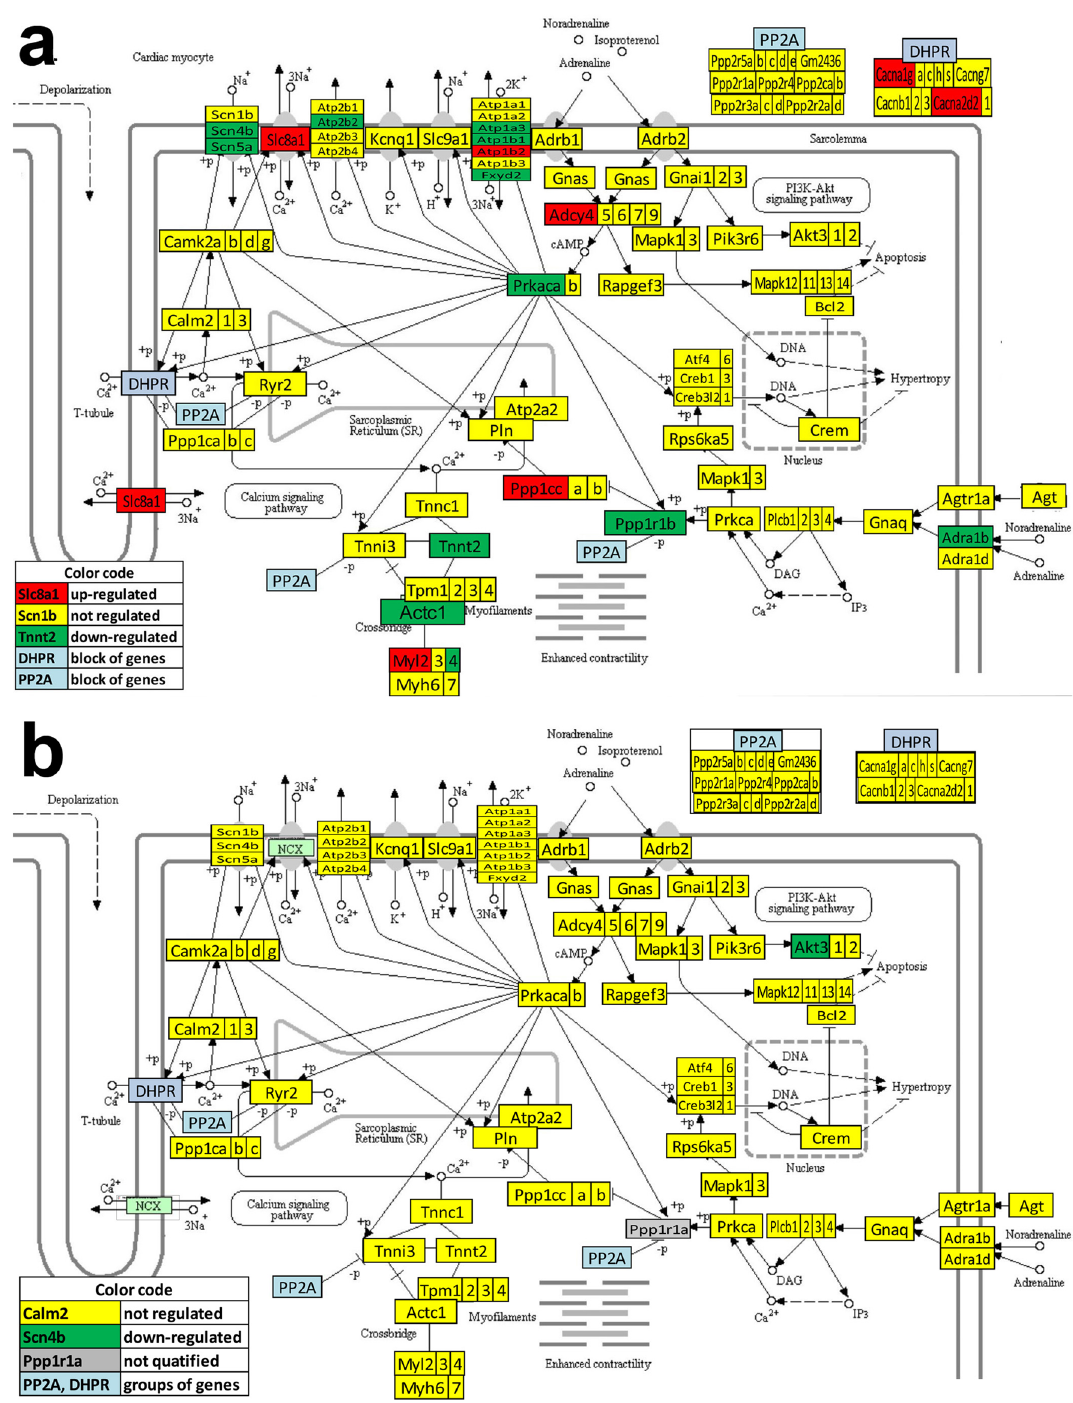
Figure 3. KEGG map ( modified from https ://www.genom e.jp/dbget -bin/www_bget?path:mmu04 261) of the differential expression of adrenergic signaling in cardiomyocytes (ASC) genes from: ( a ) the right atrium with respect to the left atrium, ( b ) the right ventricle with respect to the left ventricle. Only Akt3 was found with significantly lower expression in the right ventricle with respect to the left one. Red/green/yellow background of the gene symbol indicates up-/down-/not regulated. Genes with significant differences: actin alpha cardiac muscle 1 ( Actc1 ), adenylate cyclase 4 ( Adcy4 ), adrenergic receptor alpha 1b ( Adra1b ), angiotensin II receptor type 1b ( Agtr1b ), thymoma viral proto-oncogene 3 ( Akt3 ), Ca ++ transporting plasma membrane 2 ( Atp2b2 ), Na + /K + transporting ATPases ( Atp1a3, Atp1b1, Atp1b2 ), calcium channels ( Cacna1g, Cacna2d2 ), FXYD domain-containing ion transport regulator 2 ( Fxyd2 ), light myosins ( Myl2, Myl4 ), protein phosphatase 1 regulatory (inhibitory) subunit 1B ( Ppp1r1b ), protein kinase, cAMP dependent, catalytic, alpha ( Prkaca ), sodium channels ( Scn4b , Scn5a ), solute carrier family 8 (sodium/calcium exchanger) member 1 ( Slc8a1 ), troponin T2 cardiac ( Tnnt2